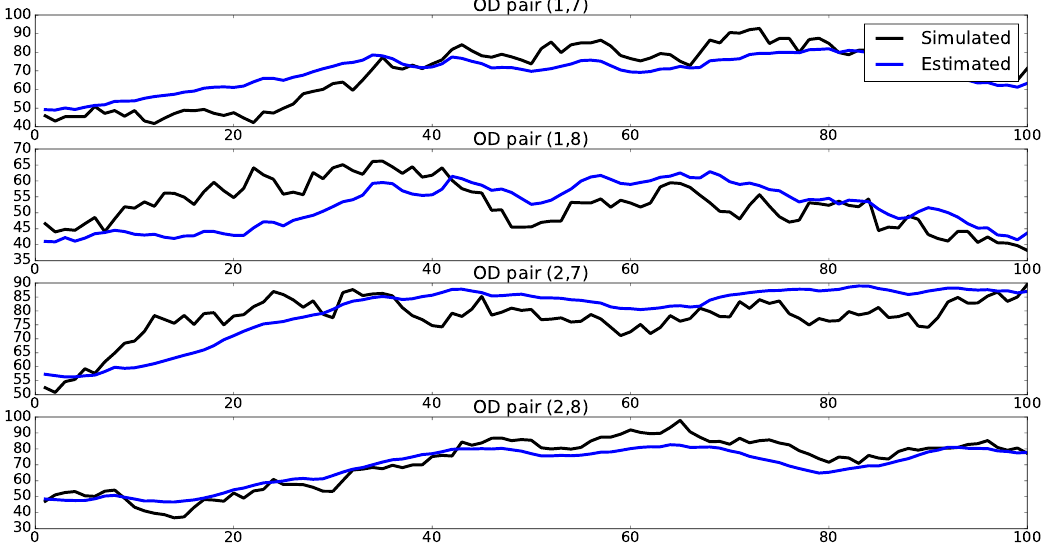
Figure 7. Simulated and estimated mean OD flows with observed traffic volumes on links 1, 7 and 9. Horizontal axes show time periods, while vertical axes show magnitude of OD flows.